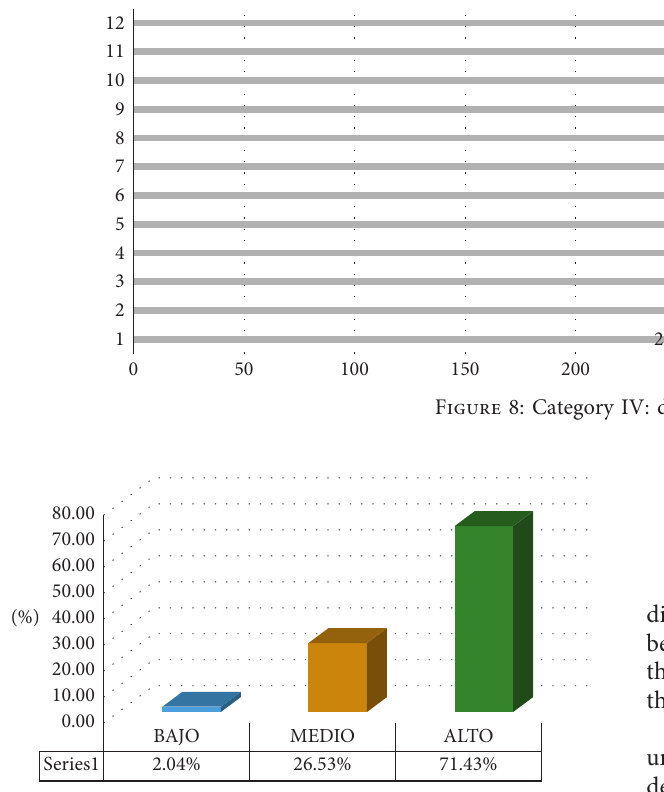
Figure 9: Category I: interaction-communication-empathy, mo- tivation, and collaboration: results.